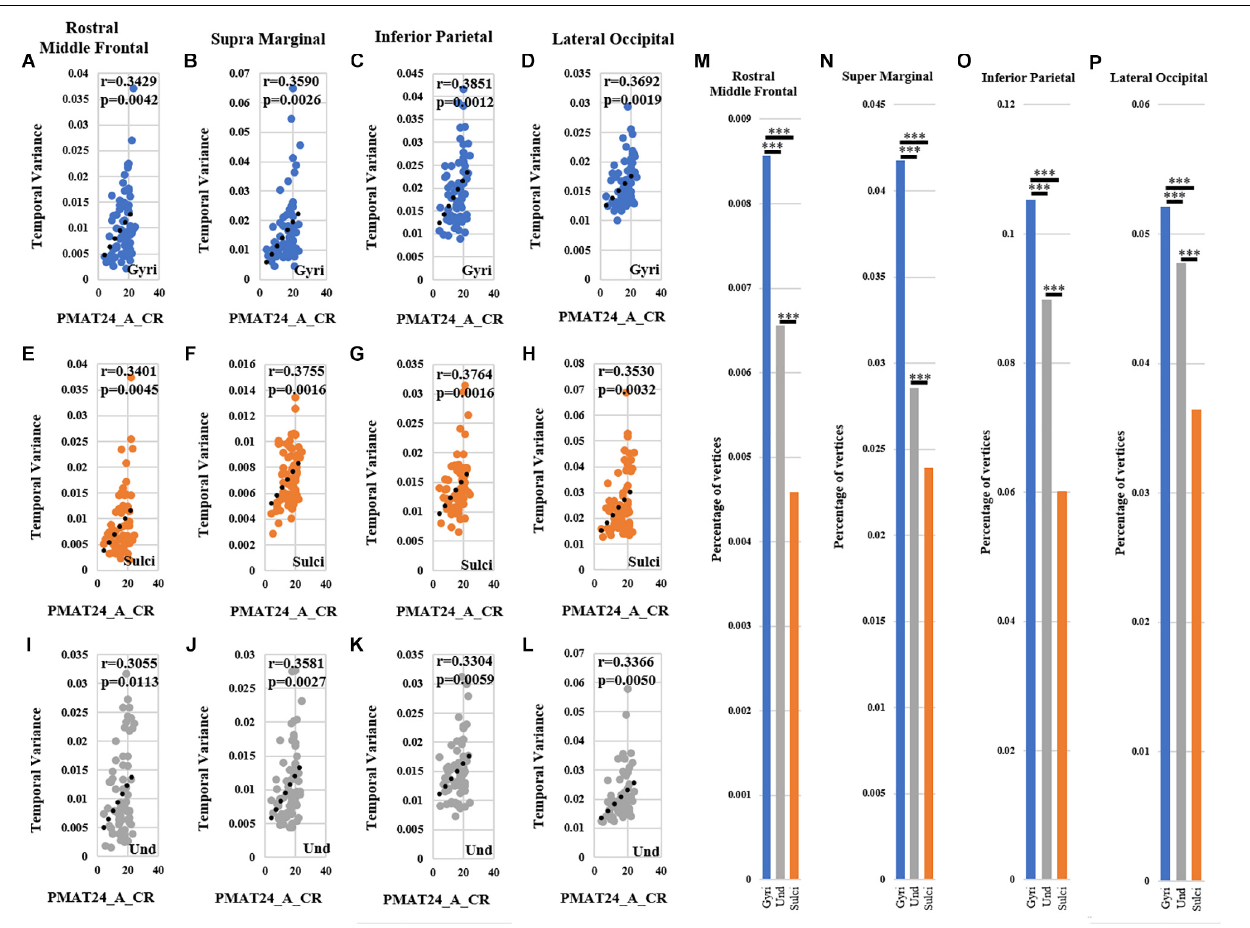
FIGURE 7 | Correlation between temporal variability of functional activity and fluid intelligence measure “number of correct responses” (PMAT24_A_CR) within each of the four ROIs. (A–D) The correlations between temporal variance and “number of correct responses” measure across all 68 subjects in one example gyral vertex within each of the four ROIs, respectively. (E–H) The correlations between temporal variance and “number of correct responses” measure across all 68 subjects in one example sulcal vertex within each of the four ROIs, respectively. (I–L) The correlations between temporal variance and “number of correct responses” measure across all 68 subjects in one example undefined vertex within each of the four ROIs, respectively. (M–P) The mean percentage of gyral/sulcal/undefined vertices with significant positive correlations with the “number of correct responses” measure across all 68 subjects. ∗∗∗ Indicates p <